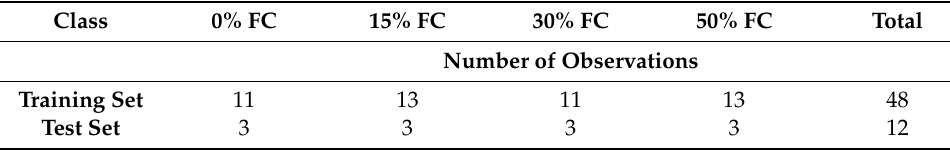
Table 1. Training and test set composition: Frozen curd